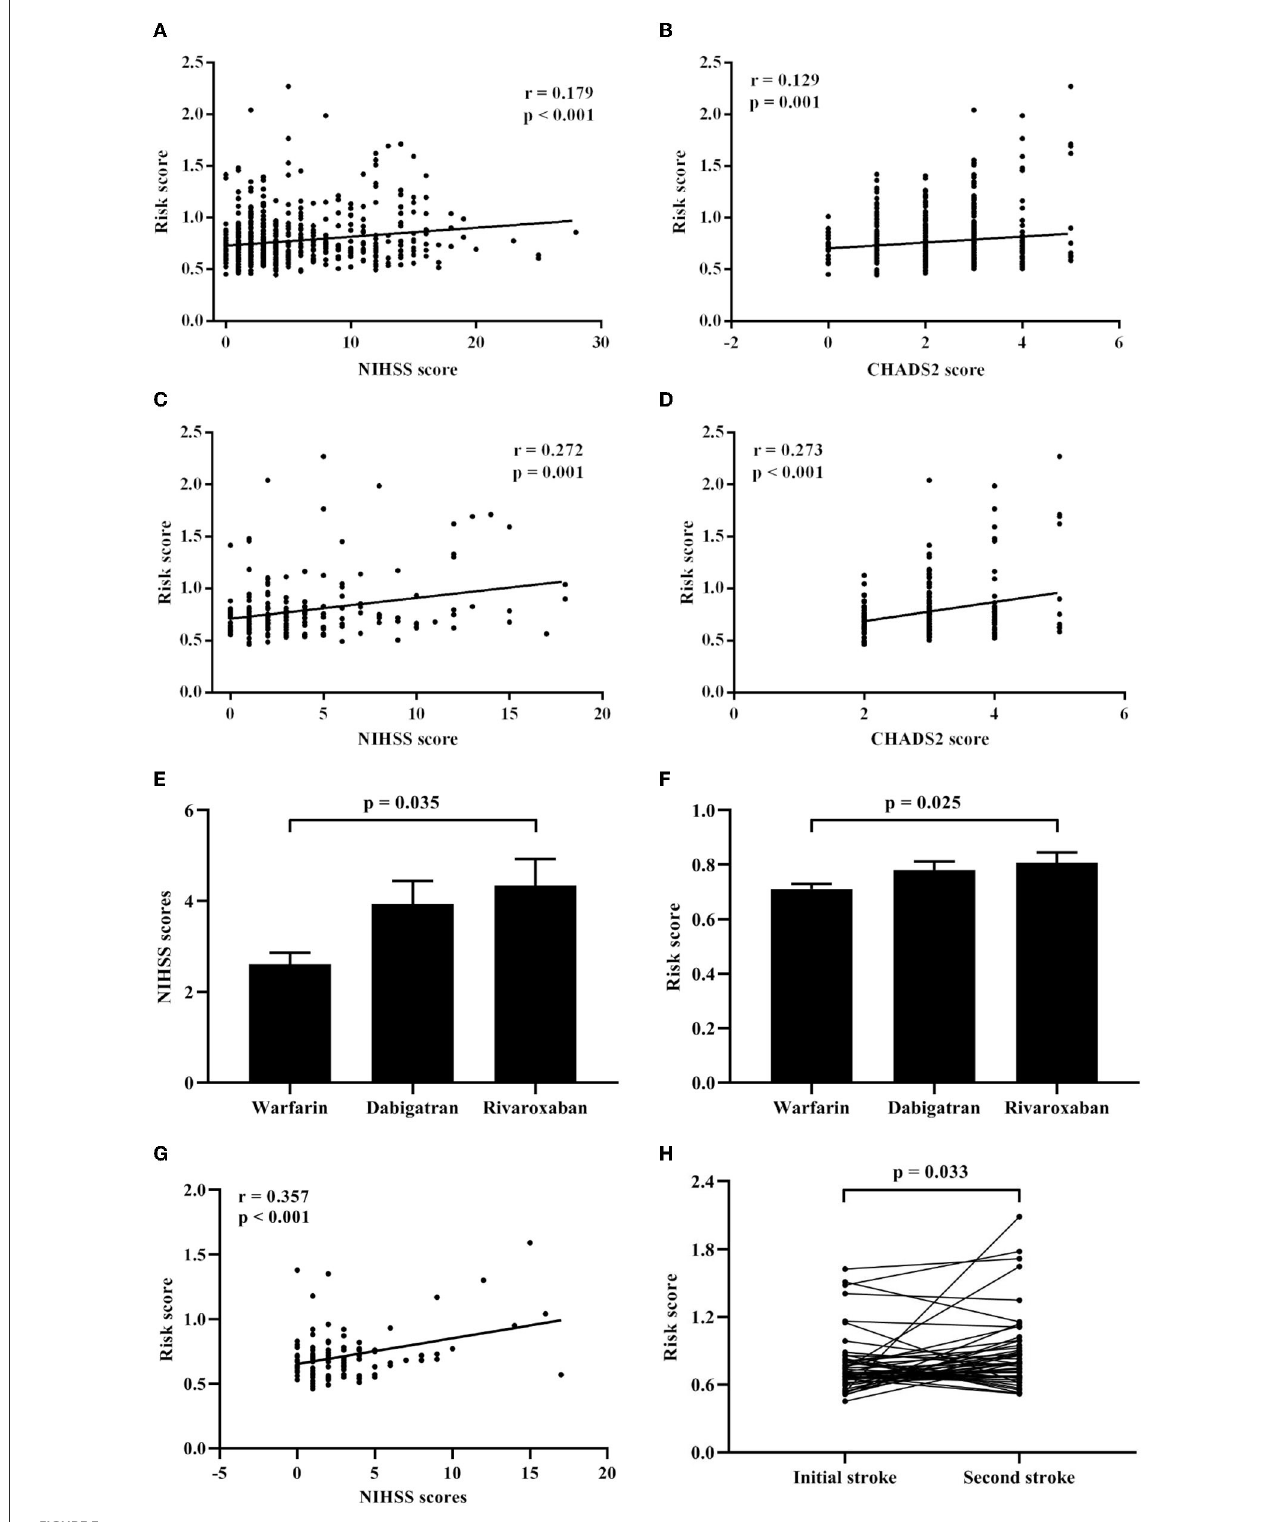
FIGURE3 Associations of the risk score with clinical features in CCE patients. (A) Correlation analysis between the risk score and the NIHSS scores in CCE patients. (B) Correlation analysis between the risk score and the CHADS2 scores in CCE patients. (C) Correlation analysis between the risk score and the NIHSS scores in initial CCE patients. (D) Correlation analysis between the risk score and the CHADS2 scores in initial CCE patients. (E) Difference of NIHSS scores among warfarin, dabigatran, and rivaroxaban groups in CCE patients. (F) Difference of the risk score among warfarin, dabigatran, and rivaroxaban groups in CCE patients. (G) Correlation analysis between the risk score and the NIHSS scores in CCE patients with the treatment of warfarin. (H) Difference analysis of the risk score between the first and second hospitalization in CCE